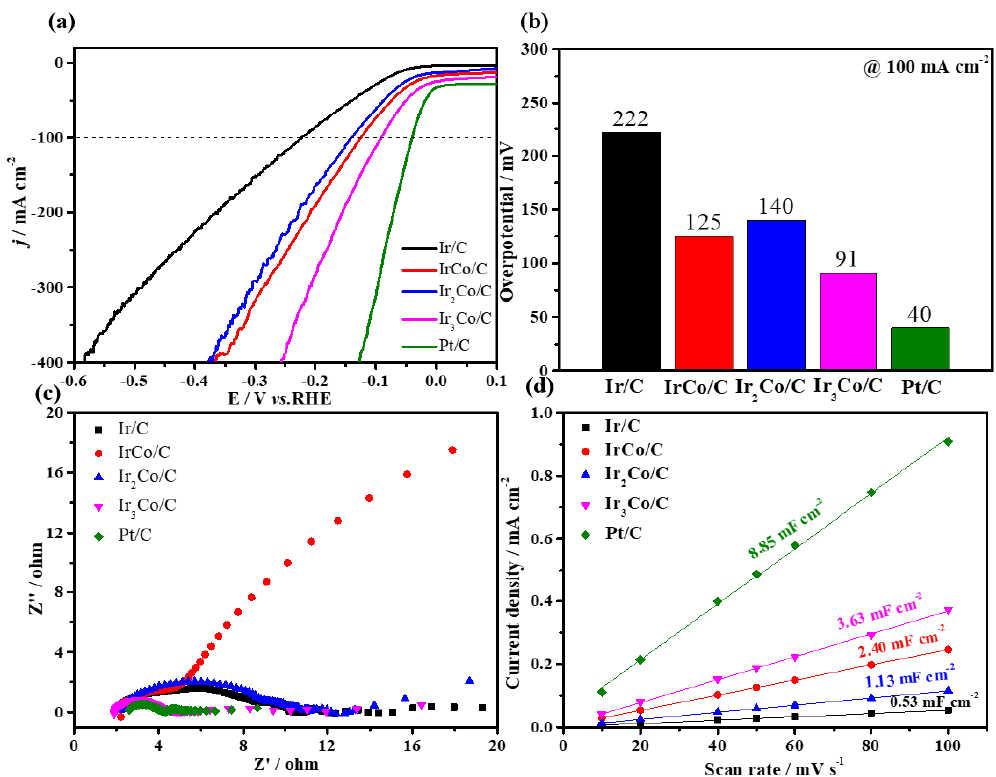
Figure 3. Electrochemical test results of different catalysts. ( a ) Polarization curves of HER in 0.5 M H 2 SO 4 . ( b ) The overpotential required to reach 100 mA cm −2 . ( c ) EIS. ( d ) Electrical double-layer capacitor (C dl ).